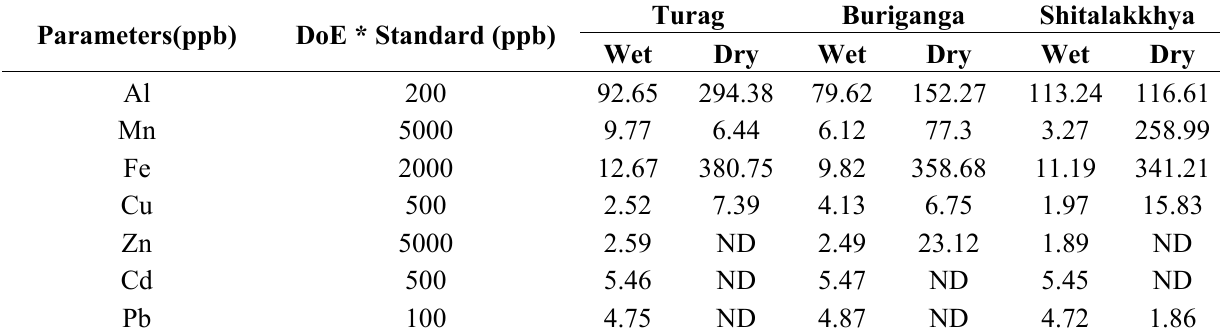
Table 2. The metal concentration during wet and dry seasons in three different rivers around Dhaka City,